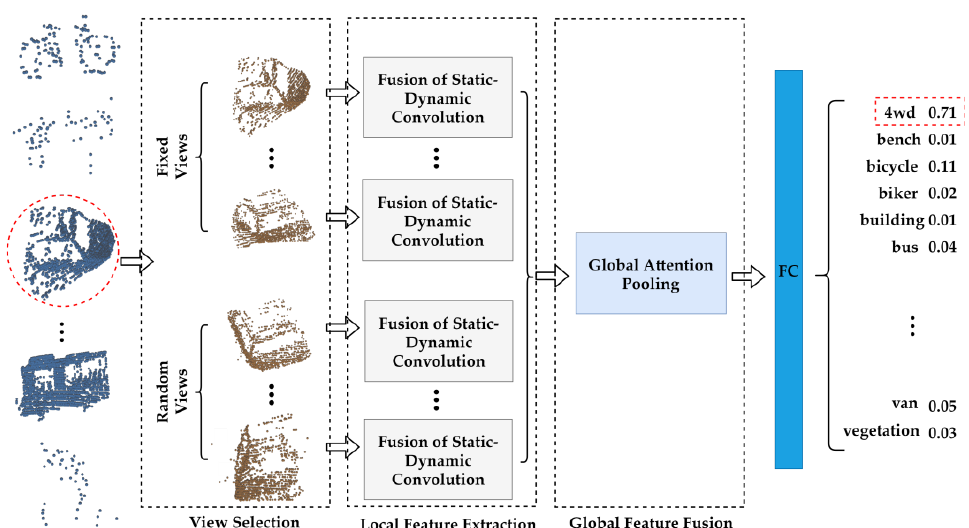
Figure 2. The framework of our FSDCNet model used to classify a 3D point cloud.